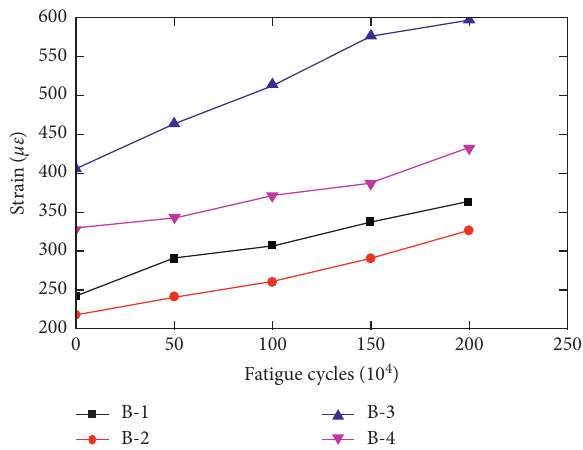
Figure 22: The relation between midspan compressive strain and fatigue cycle times for different test beams.